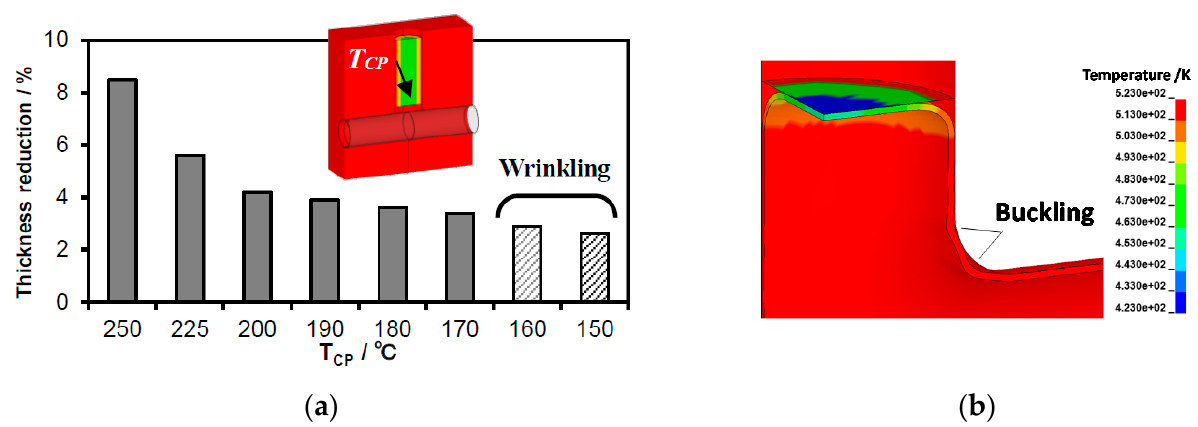
Figure 15. Effect of counter punch temperature TCP on wall thickness reduction at the center of counter punch. ( a ) Effect of TCP; ( b ) buckling occurred near the die shoulder.